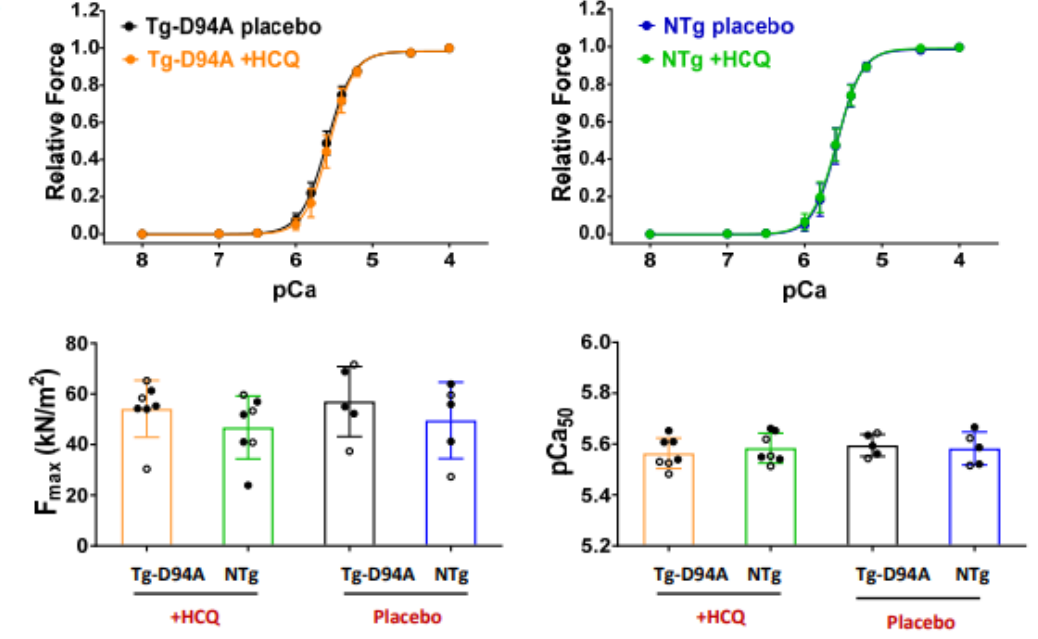
Figure 7. Contractile function in HCQ- vs. placebo-treated Tg-D94A and NTg hearts. ( A ) Force-pCa relationship in skinned LVPM fibers of HCQ and placebo-treated Tg-D94A mice ( left ) vs. NTg littermates ( right ). ( B ) Left : Maximal contractile force (in kN/m 2 ) developed by LVPM fibers at saturating calcium concentrations (pCa 4) and calculated per cross-section of muscle fiber. Right : Myofilament calcium sensitivity of force (pCa 50 ). Females are depicted with open symbols, and males are depicted with closed symbols. Each point represents an average of 2 to 4 fibers per animal. Values are the means ± SD of n = N o animals. N o = 7 mice for HCQ-treated Tg-D94A and N o = 5 mice for placebo-treated Tg-D94A. N o = 7 mice for HCQ-treated NTg and N o = 5 mice for placebo-treated NTg. No statistical significance was found by two-way ANOVA followed by Sidak’s multiple comparison test. Table 2. Contractile function in skinned LVPM fibers from HCQ- and placebo-treated Tg-D94A and NTg mice. HCQ Placebo Parameter Tg-D94A NTg Tg-D94A